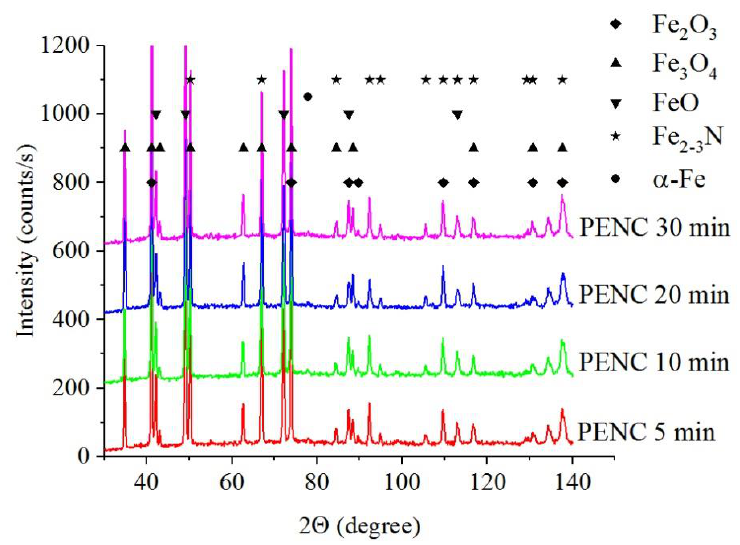
Figure 2. X-ray diffraction patterns of the steel surface layer after cathodic PENC.